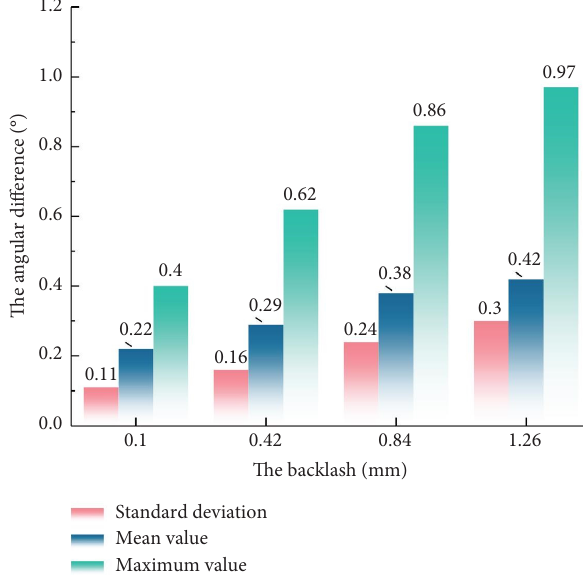
Figure 18: Te error comparison under the four types of